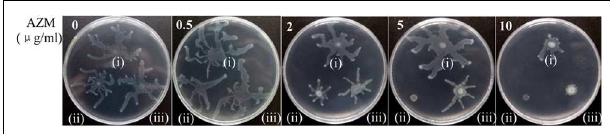
FIGURE 4 | Bacterial swarming motility. PA14 (i), the (cid:49) PA3297 mutant (ii) and the complemented strain (iii) were inoculated on plates containing indicated concentrations of AZM.